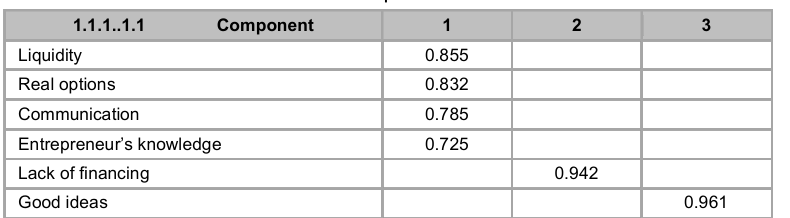
Rotated component